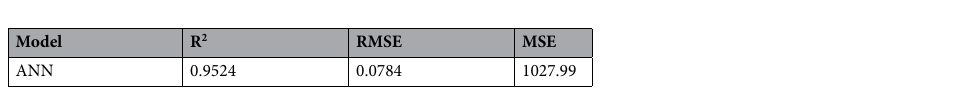
Figure 5. Prediction of the coffee cherry using ANN (MSE training and predicted values of cherry coffee by multilayer perceptron neural network versus data value, training and validation phases) (ton).